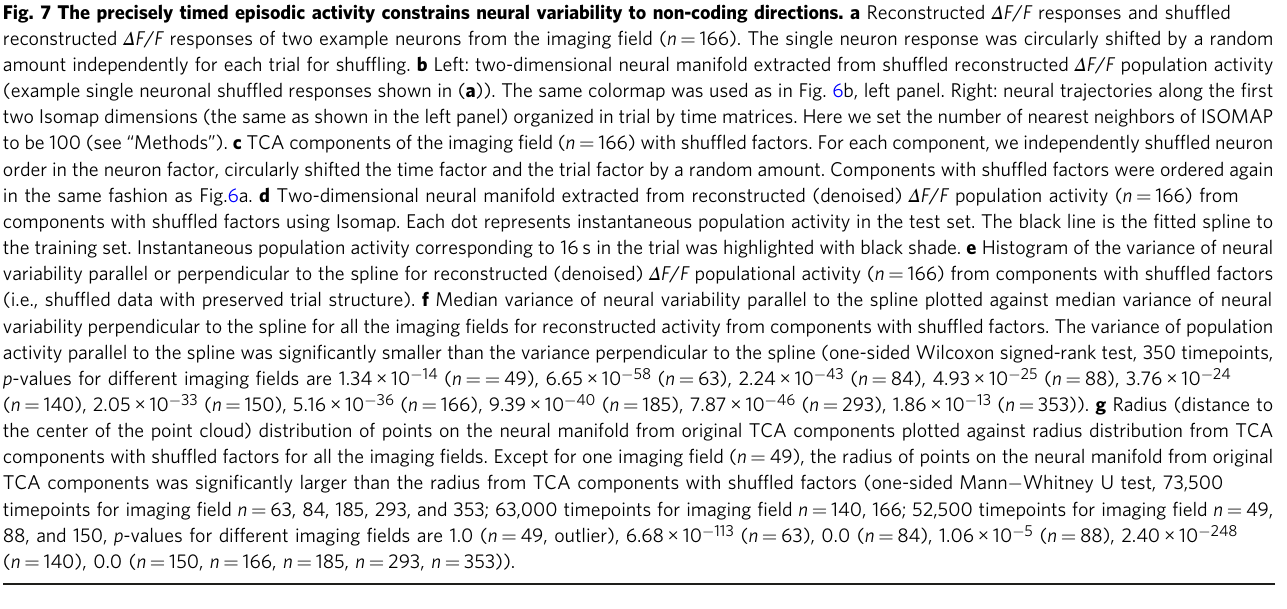
Fig. 7 The precisely timed episodic activity constrains neural variability to non-coding directions. a Reconstructed Δ F / F responses and shuf fl ed reconstructed Δ F / F responses of two example neurons from the imaging fi eld ( n = 166). The single neuron response was circularly shifted by a random amount independently for each trial for shuf fl ing. b Left: two-dimensional neural manifold extracted from shuf fl ed reconstructed Δ F / F population activity (example single neuronal shuf fl ed responses shown in ( a )). The same colormap was used as in Fig. 6b, left panel. Right: neural trajectories along the fi rst two Isomap dimensions (the same as shown in the left panel) organized in trial by time matrices. Here we set the number of nearest neighbors of ISOMAP to be 100 (see “ Methods ” ). c TCA components of the imaging fi eld ( n = 166) with shuf fl ed factors. For each component, we independently shuf fl ed neuron order in the neuron factor, circularly shifted the time factor and the trial factor by a random amount. Components with shuf fl ed factors were ordered again in the same fashion as Fig.6a. d Two-dimensional neural manifold extracted from reconstructed (denoised) Δ F / F population activity ( n = 166) from components with shuf fl ed factors using Isomap. Each dot represents instantaneous population activity in the test set. The black line is the fi tted spline to the training set. Instantaneous population activity corresponding to 16 s in the trial was highlighted with black shade. e Histogram of the variance of neural variability parallel or perpendicular to the spline for reconstructed (denoised) Δ F / F populational activity ( n = 166) from components with shuf fl ed factors (i.e., shuf fl ed data with preserved trial structure). f Median variance of neural variability parallel to the spline plotted against median variance of neural variability perpendicular to the spline for all the imaging fi elds for reconstructed activity from components with shuf fl ed factors. The variance of population activity parallel to the spline was signi fi cantly smaller than the variance perpendicular to the spline (one-sided Wilcoxon signed-rank test, 350 timepoints, p -values for different imaging fi elds are 1.34 × 10 − 14 ( n = = 49), 6.65 × 10 − 58 ( n = 63), 2.24 × 10 − 43 ( n = 84), 4.93 × 10 − 25 ( n = 88), 3.76 × 10 − 24 ( n = 140), 2.05 × 10 − 33 ( n = 150), 5.16 × 10 − 36 ( n = 166), 9.39 × 10 − 40 ( n = 185), 7.87 × 10 − 46 ( n = 293), 1.86 × 10 − 13 ( n = 353)). g Radius (distance to the center of the point cloud) distribution of points on the neural manifold from original TCA components plotted against radius distribution from TCA components with shuf fl ed factors for all the imaging fi elds. Except for one imaging fi eld ( n = 49), the radius of points on the neural manifold from original TCA components was signi fi cantly larger than the radius from TCA components with shuf fl ed factors (one-sided Mann − Whitney U test, 73,500 timepoints for imaging fi eld n = 63, 84, 185, 293, and 353; 63,000 timepoints for imaging fi eld n = 140, 166; 52,500 timepoints for imaging fi eld n = 49, 88, and 150, p -values for different imaging fi elds are 1.0 ( n = 49, outlier), 6.68 × 10 − 113 ( n = 63), 0.0 ( n = 84), 1.06 × 10 − 5 ( n = 88), 2.40 × 10 − 248 ( n = 140), 0.0 ( n = 150, n = 166, n = 185, n = 293, n =